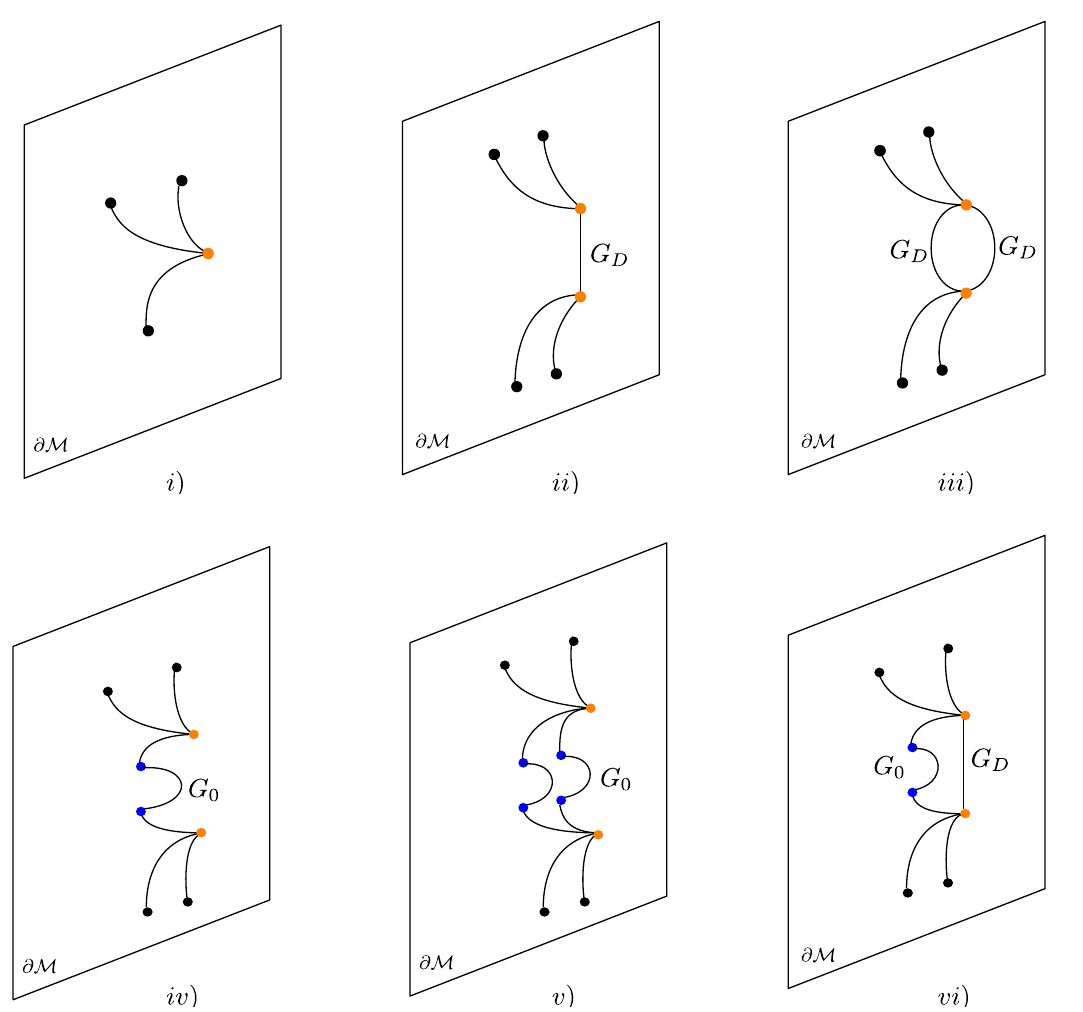
Figure 5 . Sample of boundary connected correlators. Orange and blue points are respectively integrated over M and ∂ M